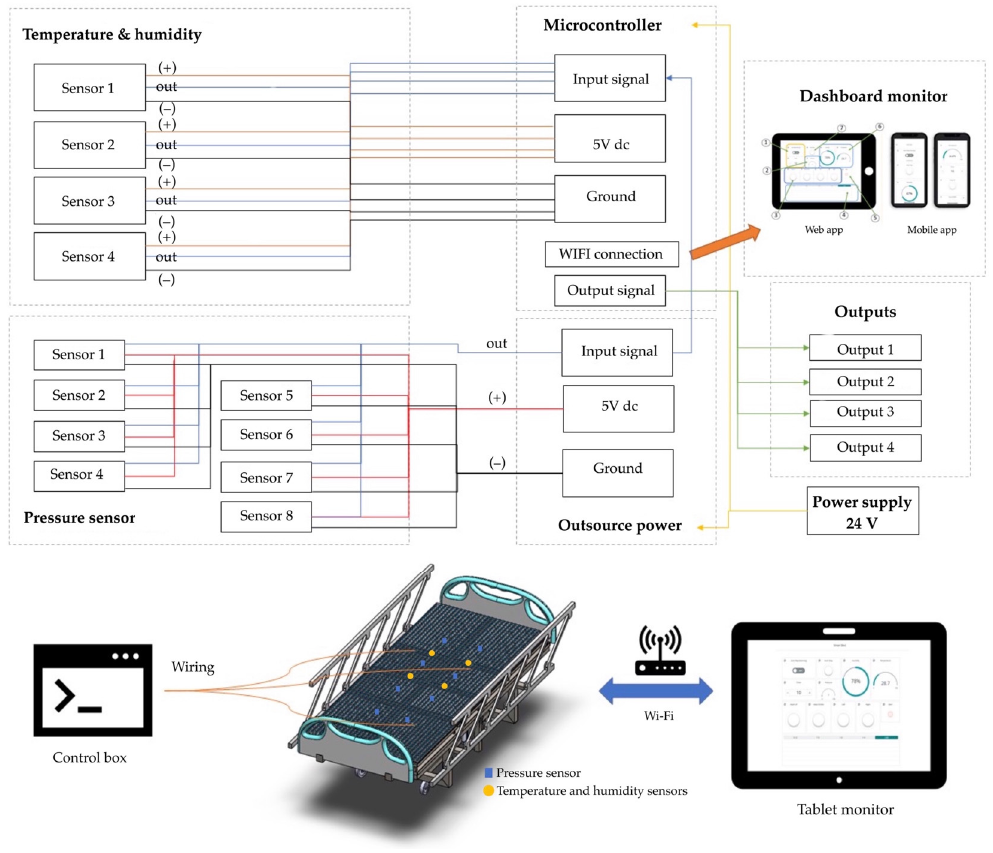
Figure 7. Control system of the electronic signal mechanism.